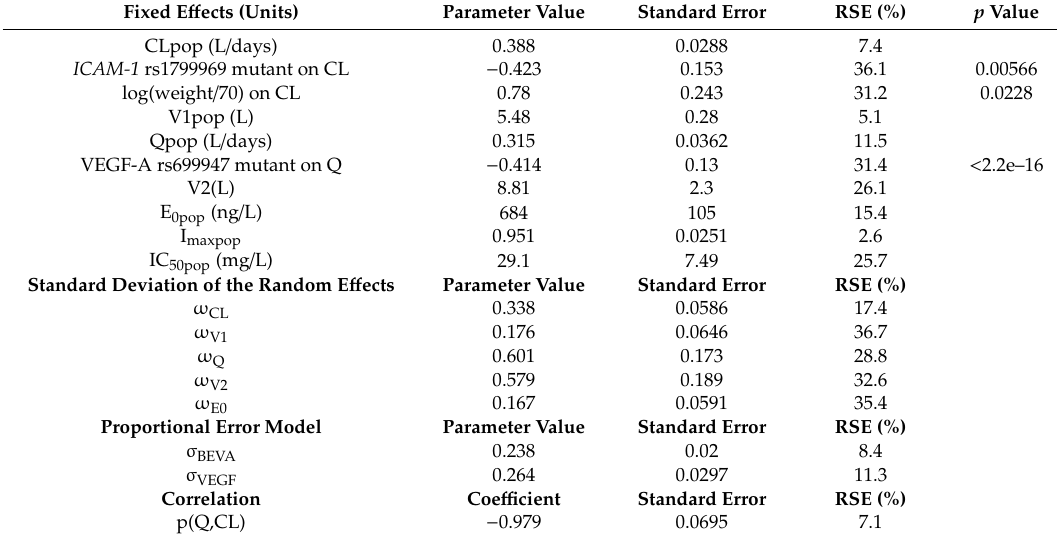
Table 3. Parameter estimates of the pharmacokinetic / pharmacodynamic (PK / PD) model. Fixed E ff ects